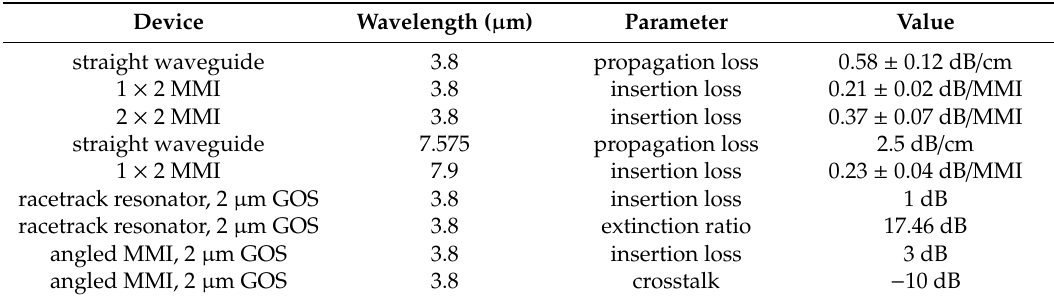
Table 5. Experimental performance of 3 µm thick germanium-on-silicon (GOS) photonic components, which will be available in the CORNERSTONE Process Design Kit (PDK).